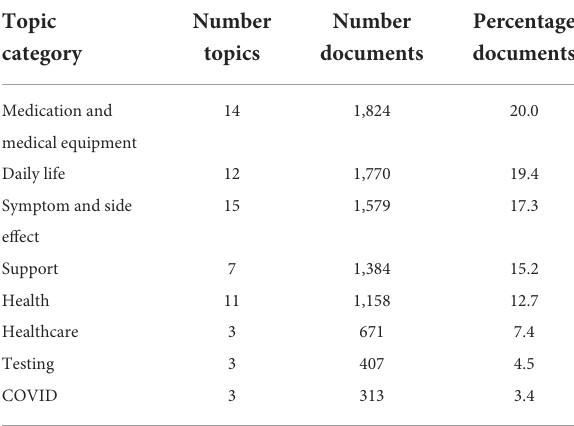
TABLE 2 Topic size and category names for the 68 derived topics using Top2Vec with doc2vec embedding